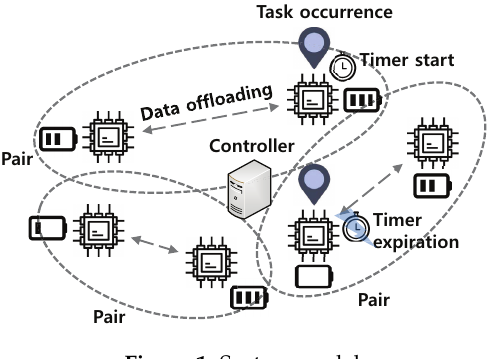
Figure 1. System